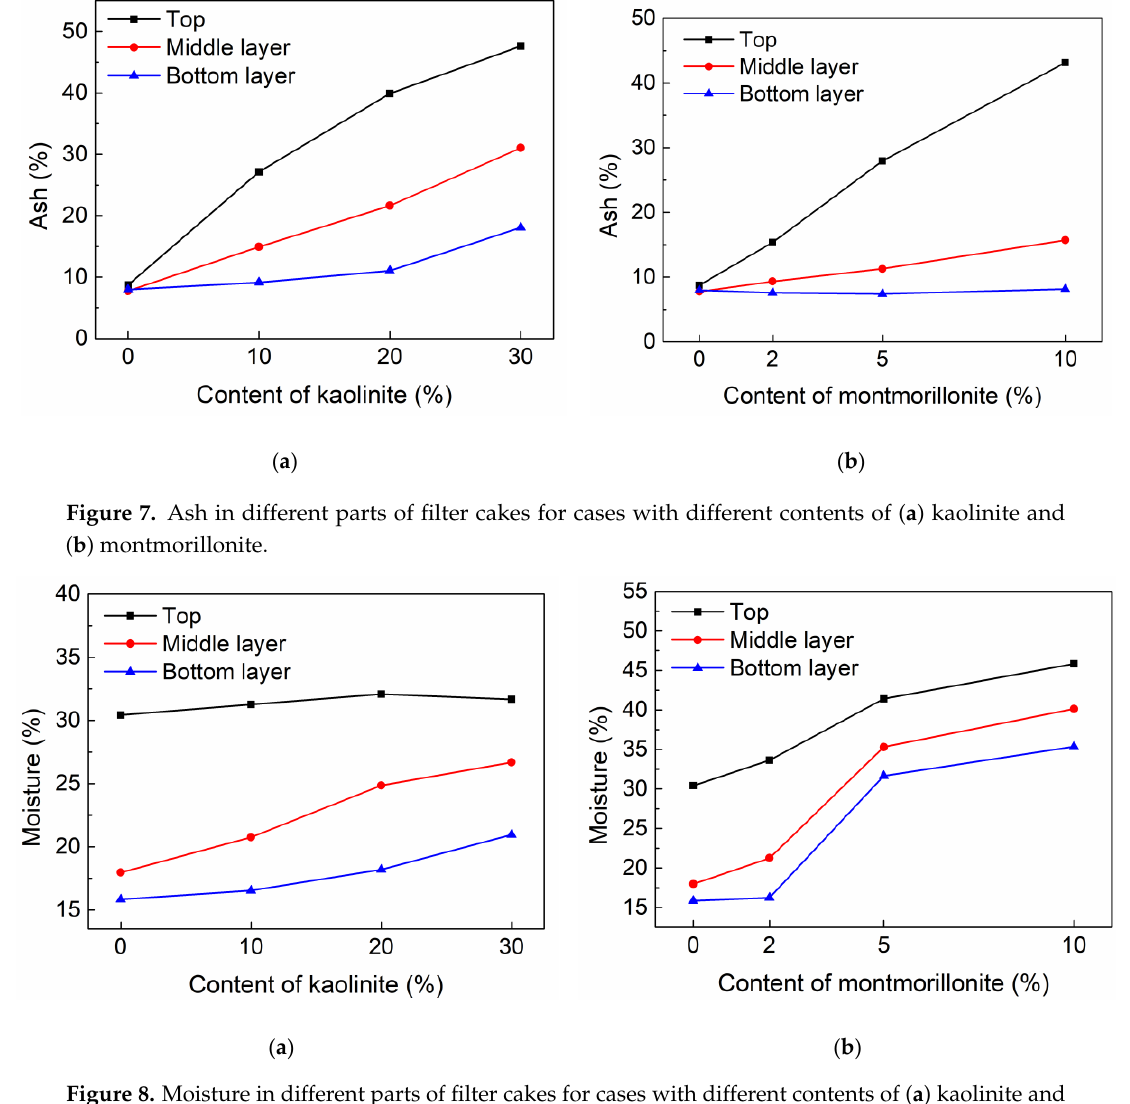
Figure 7. Ash in different parts of filter cakes for cases with different contents of ( a ) kaolinite and ( b ) montmorillonite.